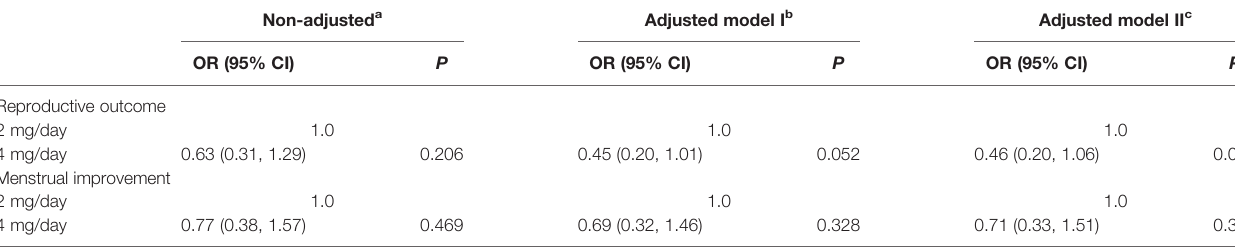
TABLE 4 | Multivariate logistic regression of the propensity-matched